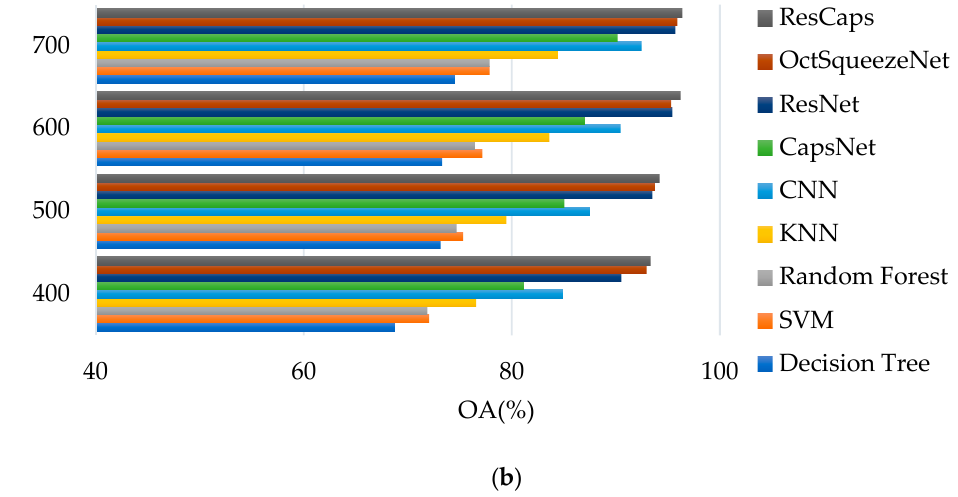
Figure 7. Classification results of different methods: (a) Bayview Park data set; (b) Recology data set.